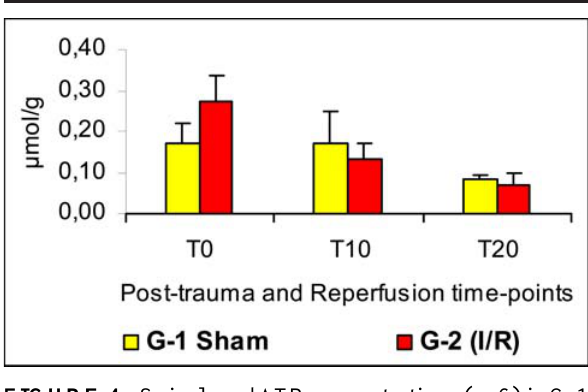
FIGURE 4 - Spinal cord ATP concentrations (n=6) in G-1 and G-2 groups tissue homogenates. Values are expressed as mean±S.E.M.